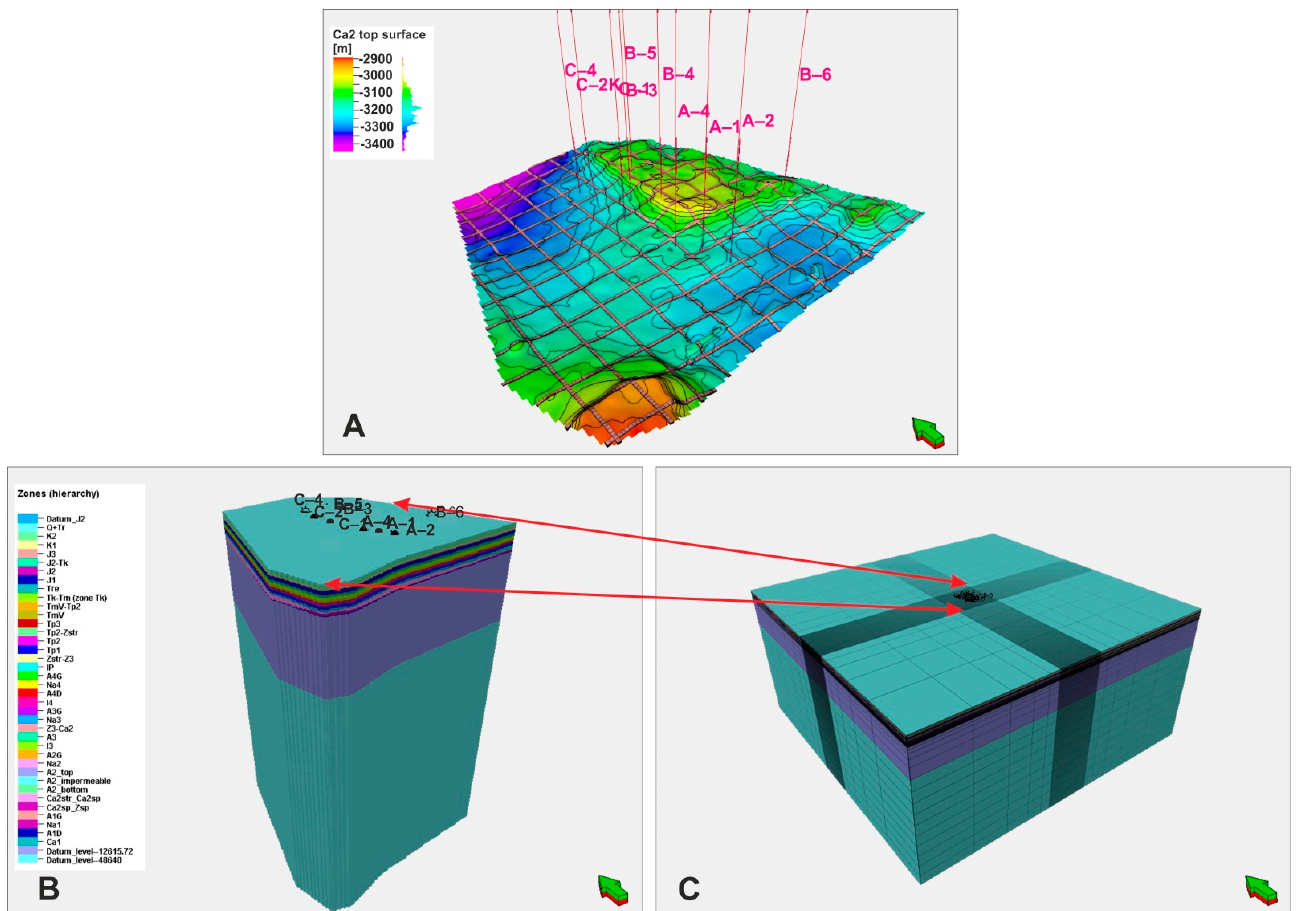
Figure 3. Visualisation of the model structures: ( A )—3D model reservoir rock, ( B )—3D structure including the over and underburden, ( C )—the geometry of the final 3D grid used in the geomechanic simulator, including over-, under-, and side-burden.